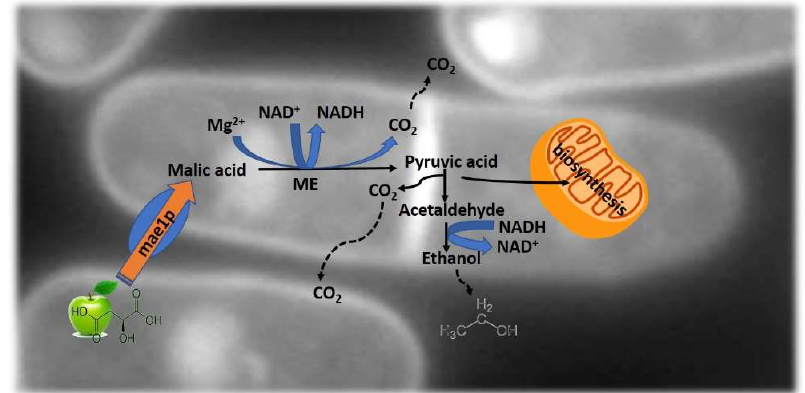
Figure 4. Schematic representation of the maloalcoholic pathway. Malic acid is transported into the yeast cell by mae1p carboxylic acid transporter. The malic enzyme (ME) converts malate into pyruvate, supplying pyruvic acid to the mitochondria for biosynthesis.